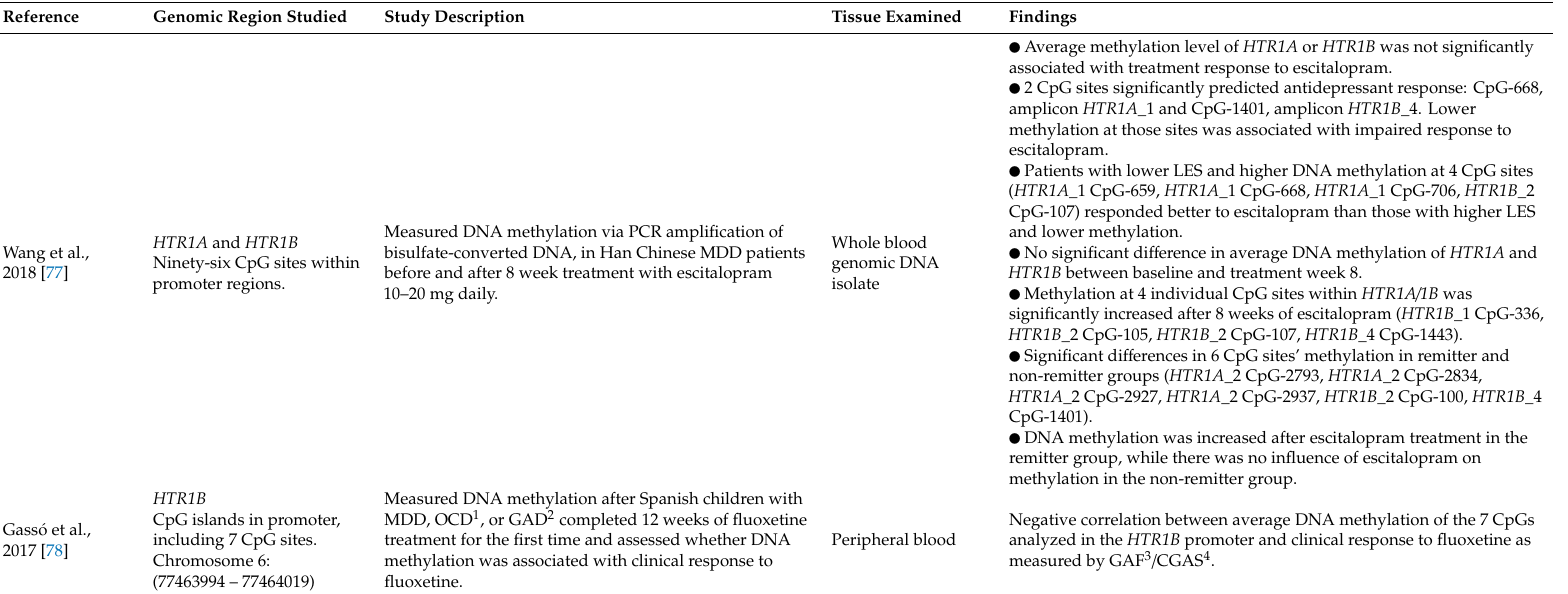
Table 4. Summaries of studies exploring relationship of antidepressants and DNA methylation of serotonin receptor